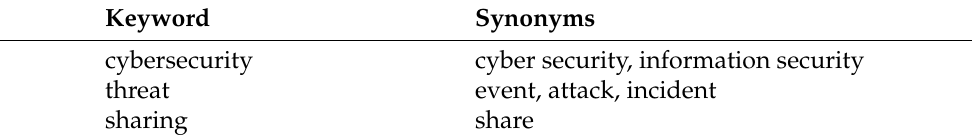
Table 1. Keywords and accompanying synonyms used in our search of the Scopus database.